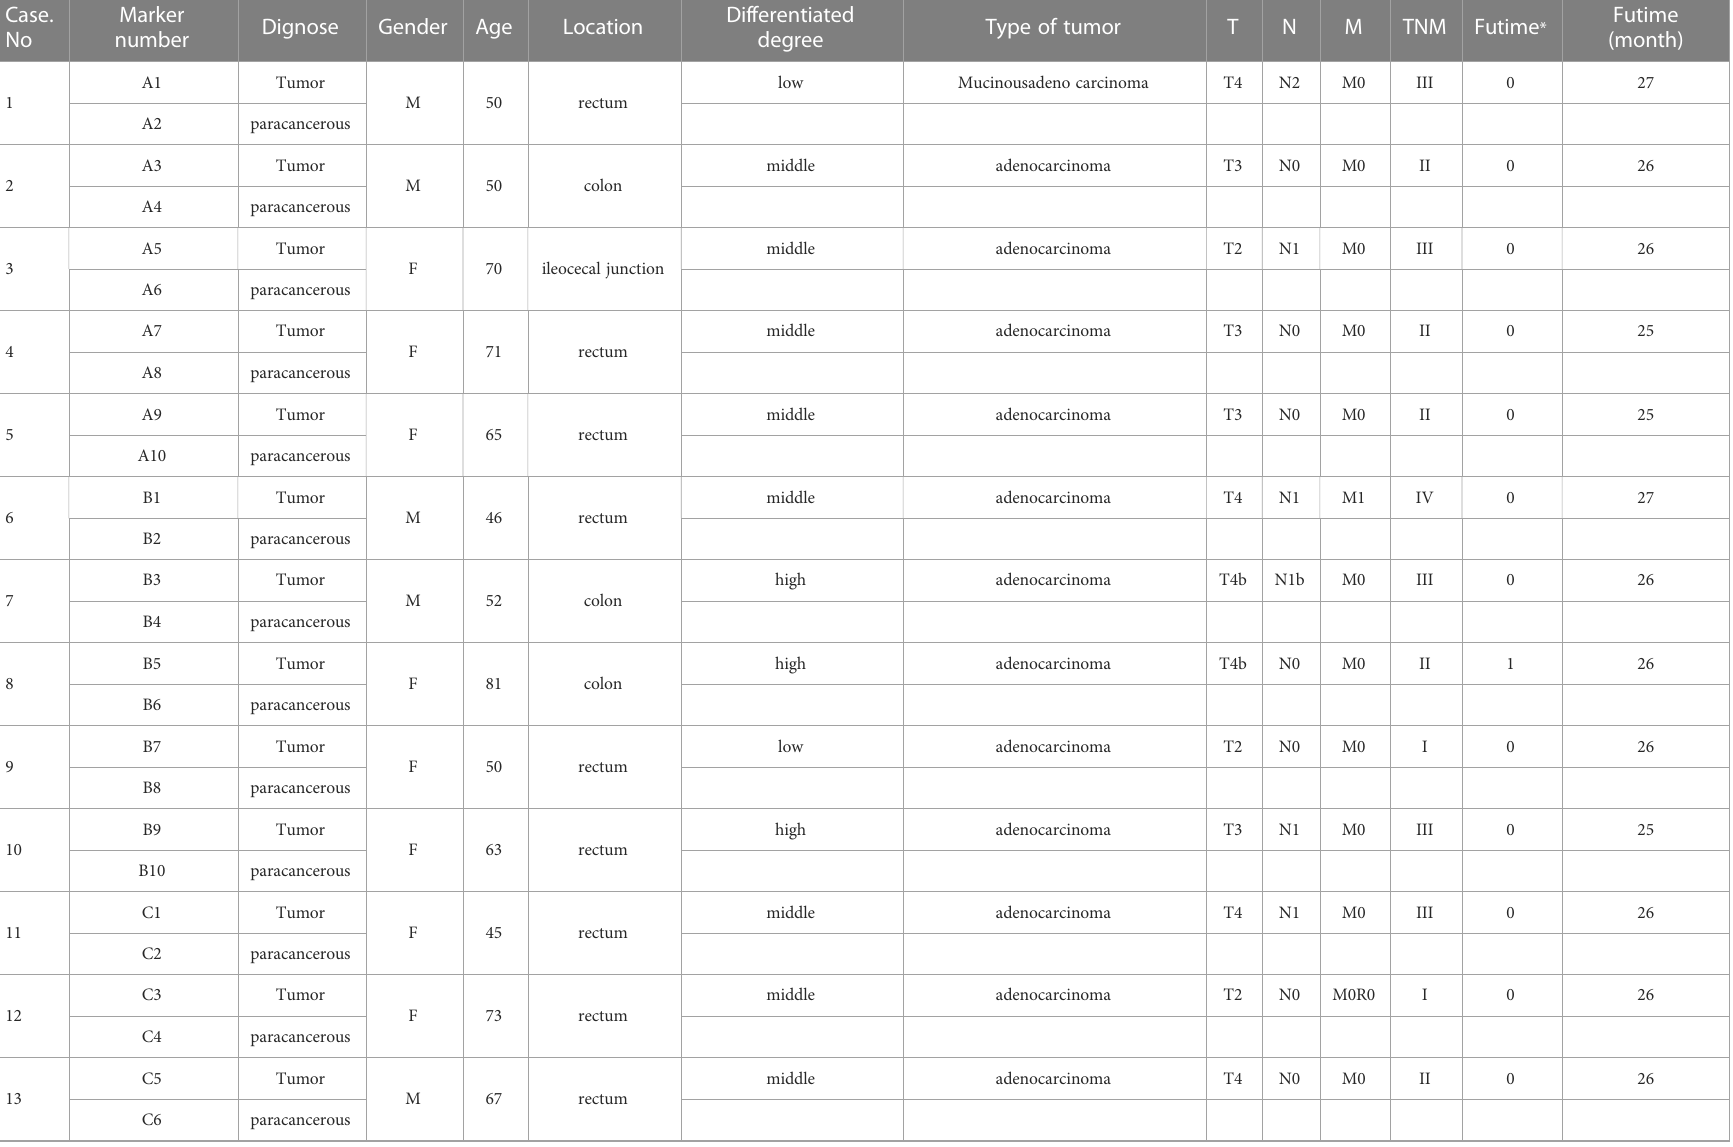
TABLE 1 Clinical characteristics of the patients.